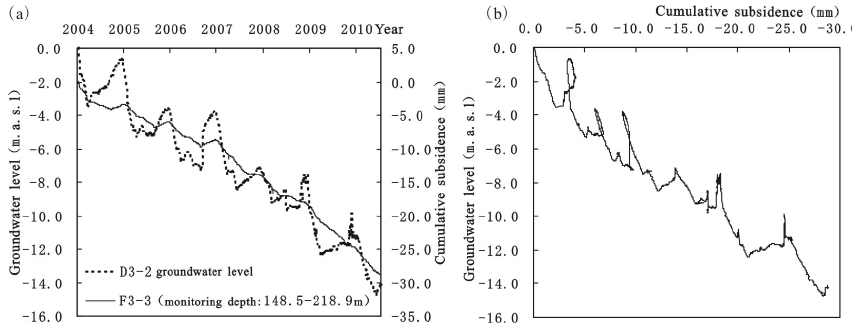
Figure 6. Deformation of the deep soil mass vs. its corresponding groundwater level at layered mark F3-3. (a) Groundwater level and deformation over time, (b) groundwater level vs. deformation hysteresis